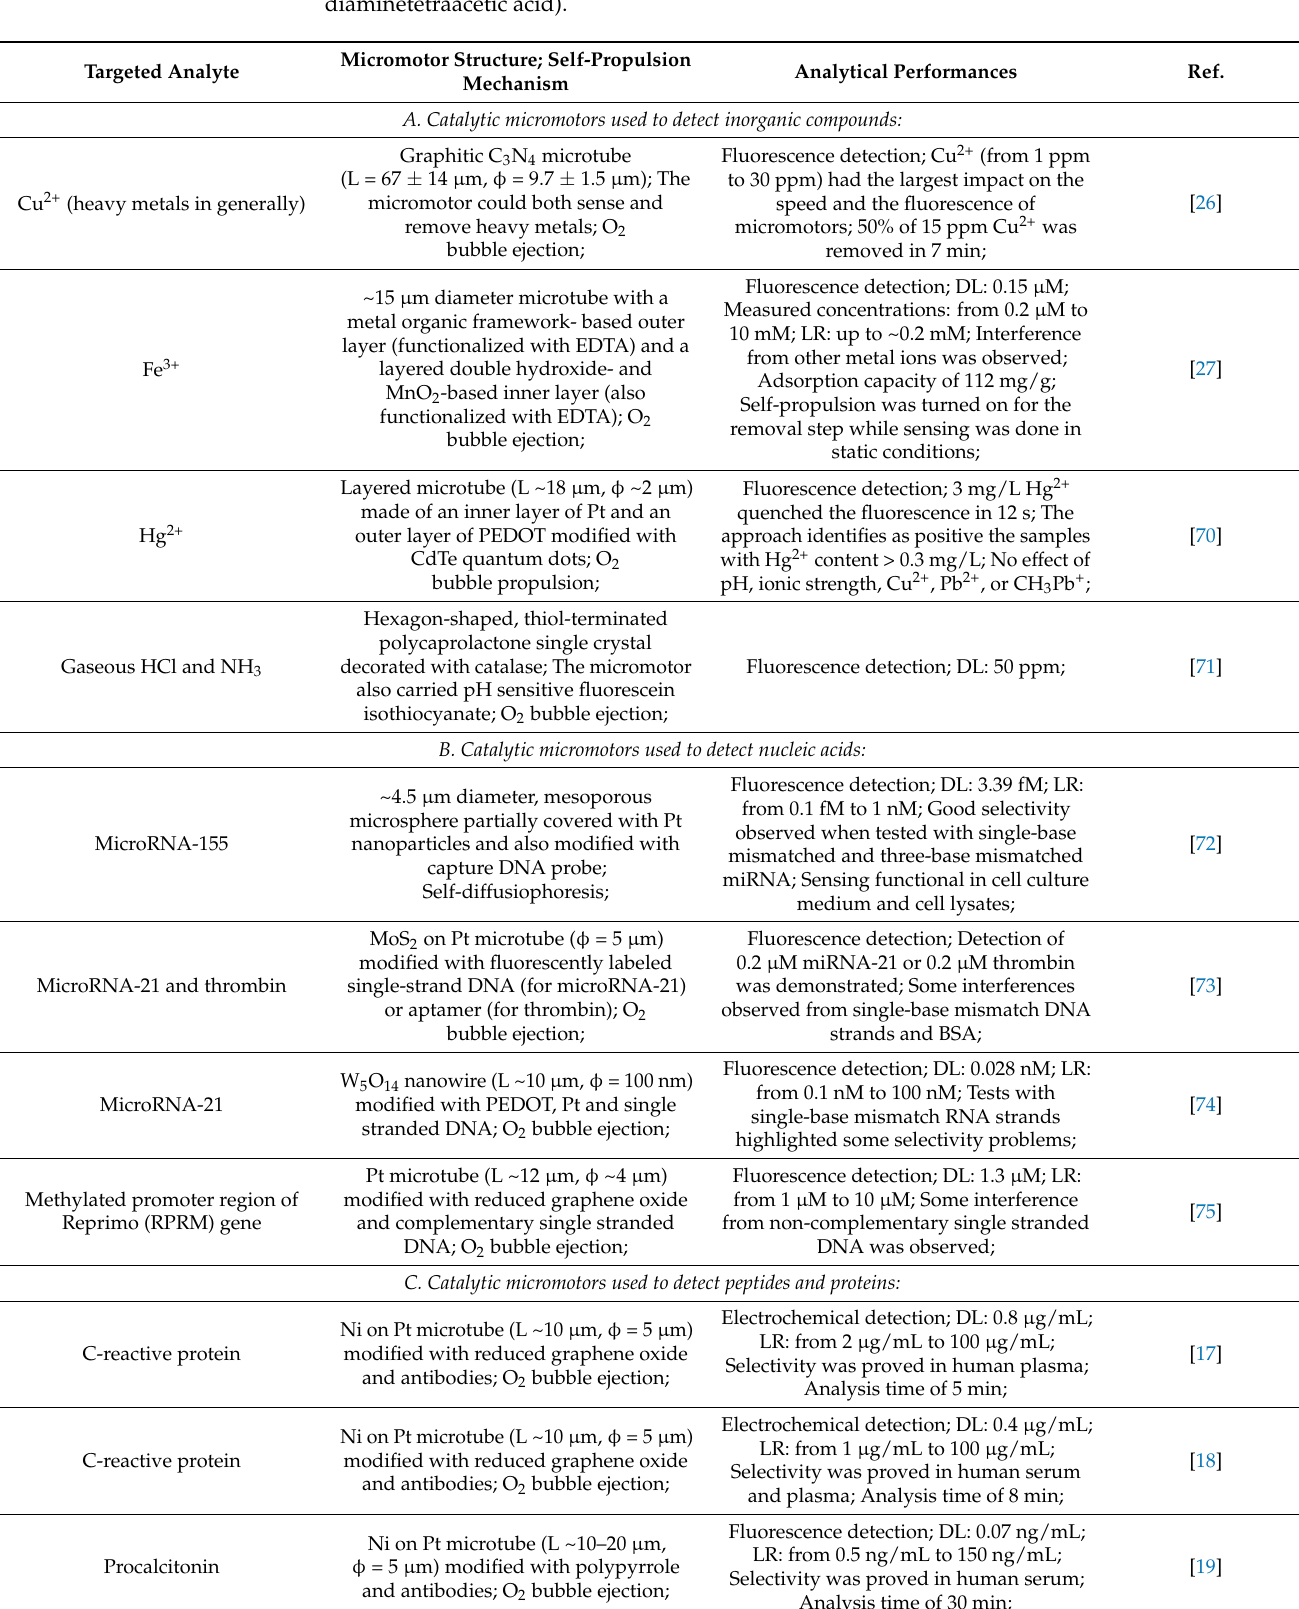
Table 3. Examples of micromotors which were used for sensing analytes which are not directly involved in the catalytic processes propelling the micromotors; (Used abbreviation: EDTA = ethylene- diaminetetraacetic